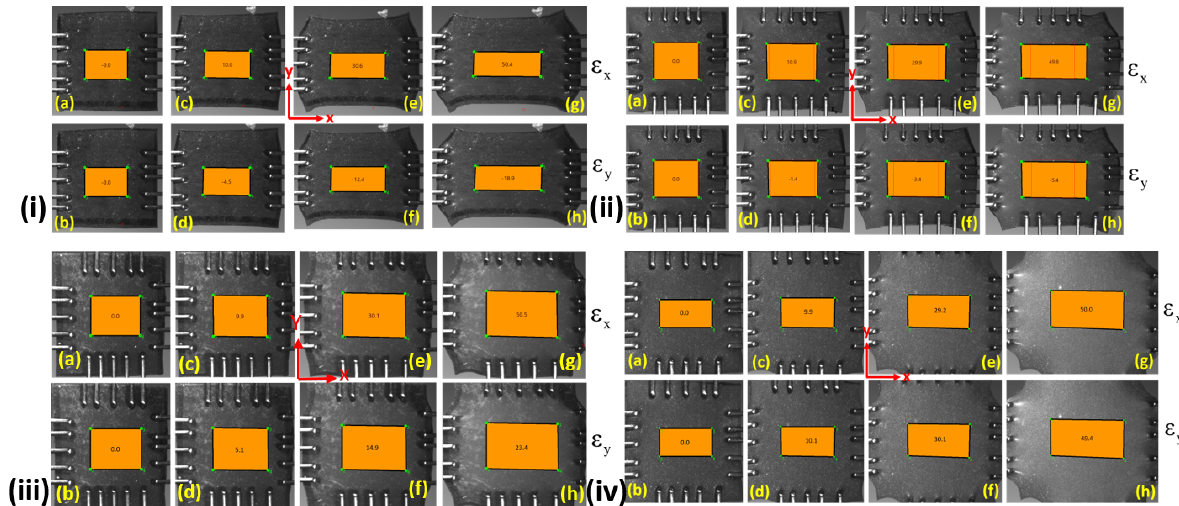
Figure 4. Strain maps developed under all possible modes of deformation are represented for (i) UX (ii) PS (iii) BX (iv) EB in the biaxial testing device. The strain maps for X direction are shown in ( a , c , e , g ) and corresponding strain maps for Y direction are shown in ( b , d , f , h ), respectively for each deformation